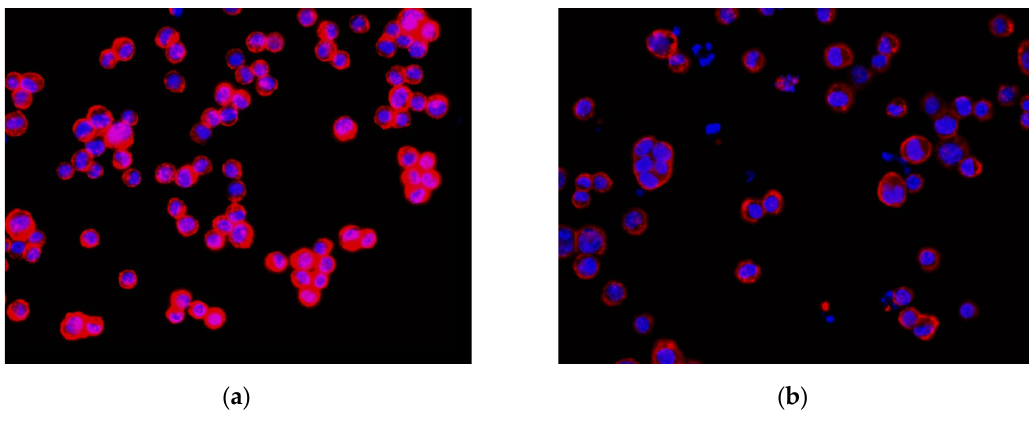
Figure 9. Colon cancer cell images of HCT116: ( a ) HCT116 cell with DMSO(dimethyl sulfoxide) (no.4484); ( b ) HCT116 cell with dinaciclib (no.4496).